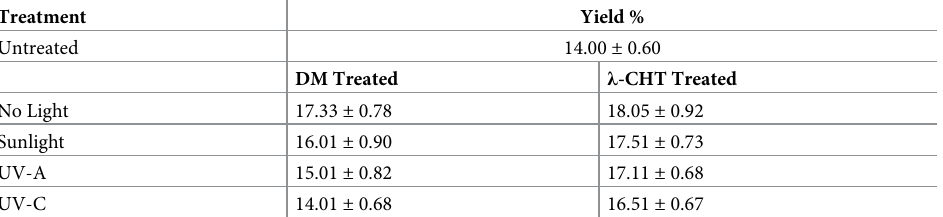
Table 1. Extraction yield (%) in methanol of cauliflower with and without pesticides and before and after light effect.